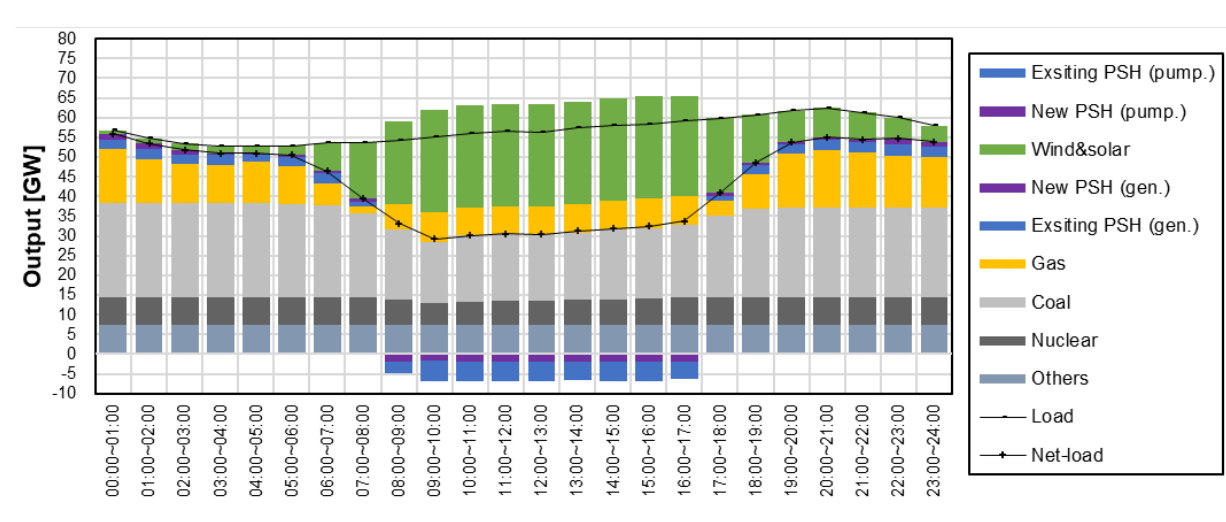
Figure 12. The UC solution diagram of Scenario B.